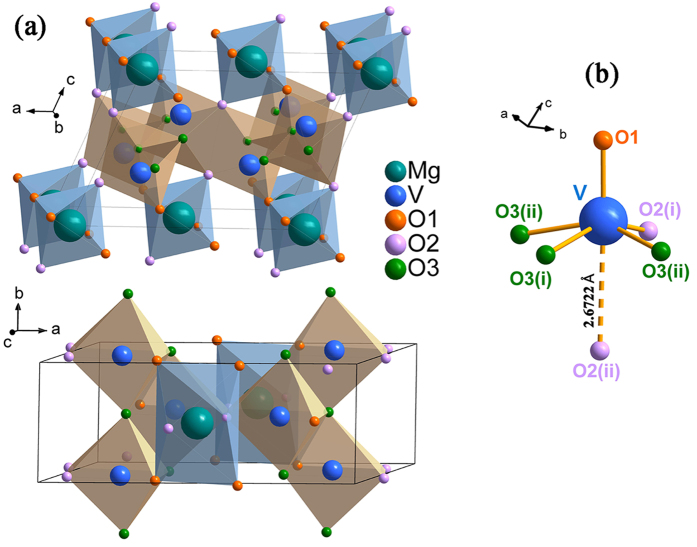
(a) Schematic view of the crystal structure and (b) V-O bonding diagram of MgV2O6 (space group C2/m).